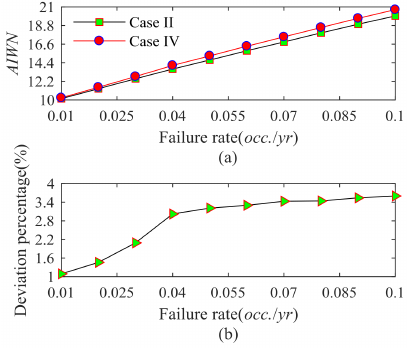
Figure 8. ( a ) Average Interrupted WTGs Number index (AIWN) index changes with failure rate; ( b ) Deviation percentage of AIWN index between chain-type I and chain-type